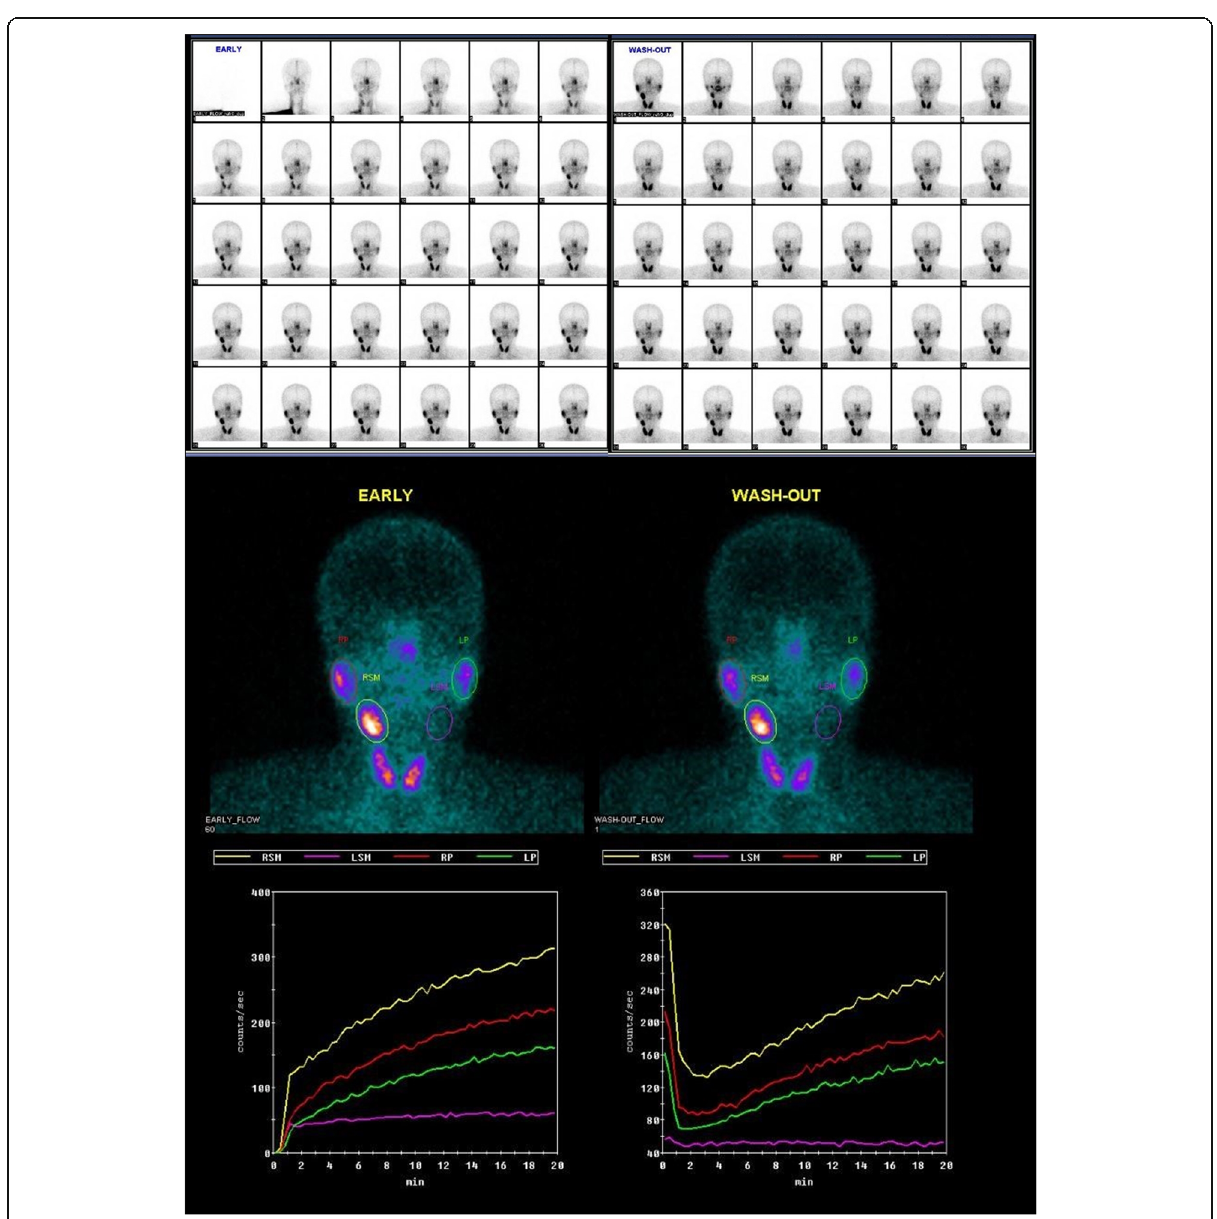
Fig. 2 Preoperative technetium-99m pertechnetate salivary gland scintigraphy revealed that right salivary glands were within normal limits but with no definite radiotracer excretion in the Lt. submandibular